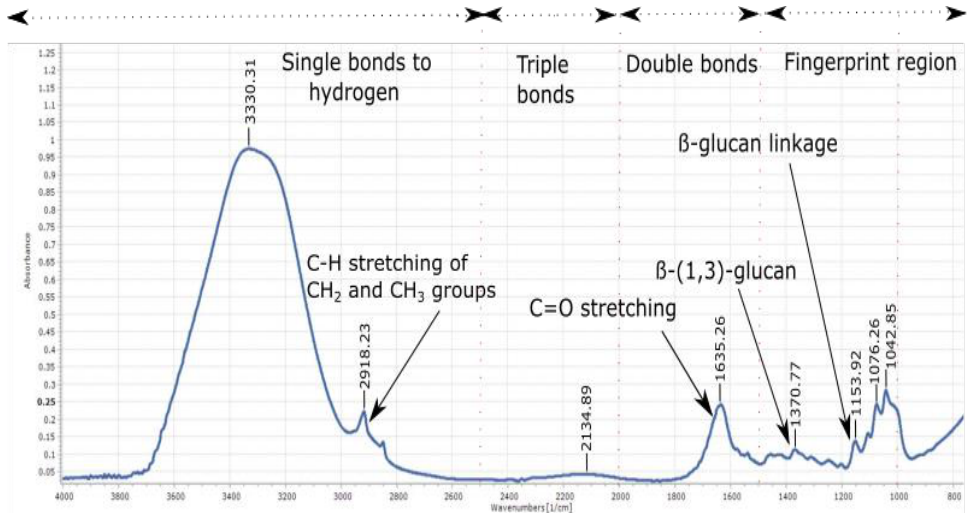
Figure 6. ATR–FTIR spectra of spent brewer’s yeast β Figure 6. ATR – FTIR spectra of spe nt brewer’s yeast β– glucan. The absorption band found at 1635.26 cm −1 can be caused by the stretching vibra- tions of C=O groups. The absorption bands characteristic to β -glucan fractions were ob- served at 1370.77, 1153.92, 1076.26, and 1042.85 cm −1 , respectively, the first one being at- tributed to β -(1,3) linkage [33,34]. The band observed at 1076.26 cm −1 could be attributed to the characteristic C-O-C linkage to glycosidic bonds with cyclic structures, demon- strating that the β -glucan is not broken [35].